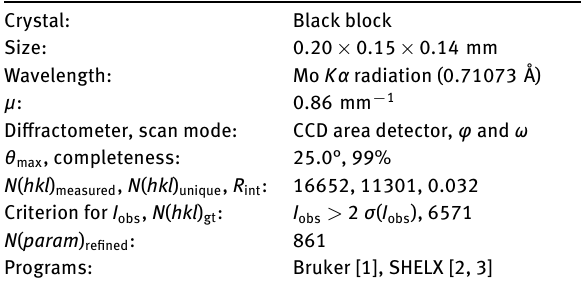
Table 2: Fractional atomic coordinates and isotropic or equivalent isotropic displacement parameters (Å 2